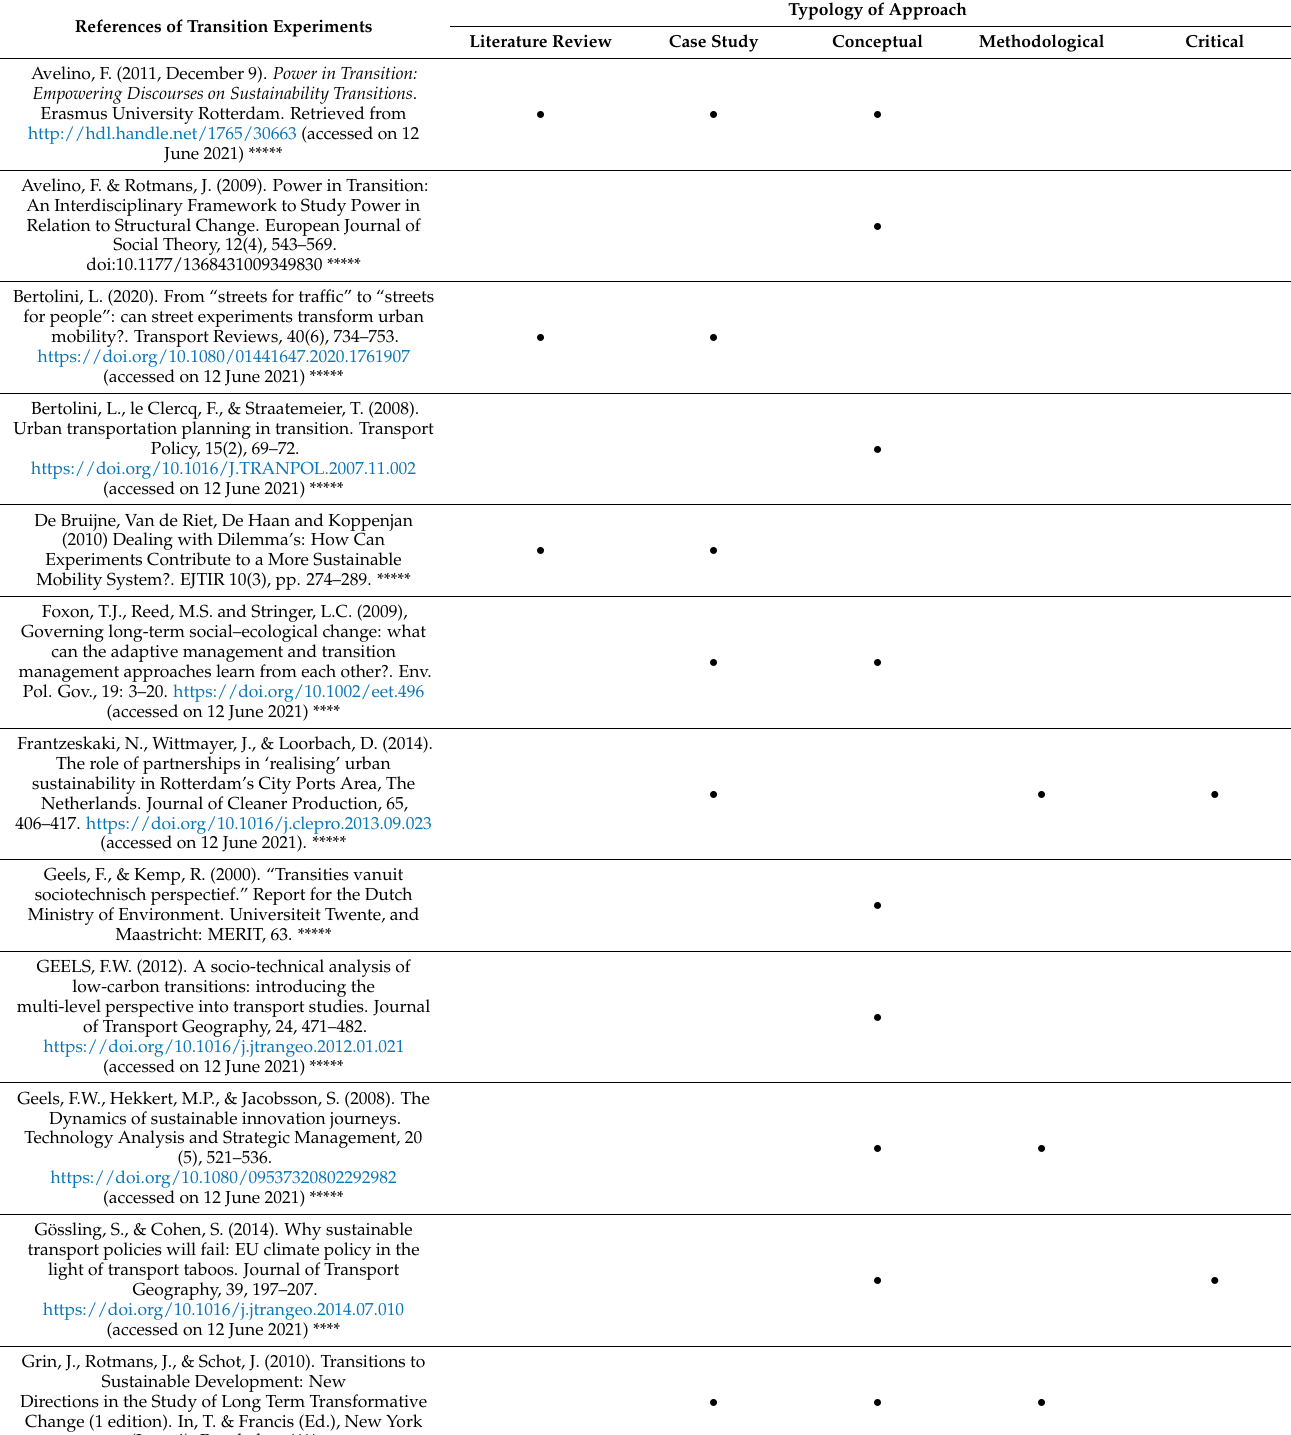
Table 1. Types of research approach of the main publications of TE